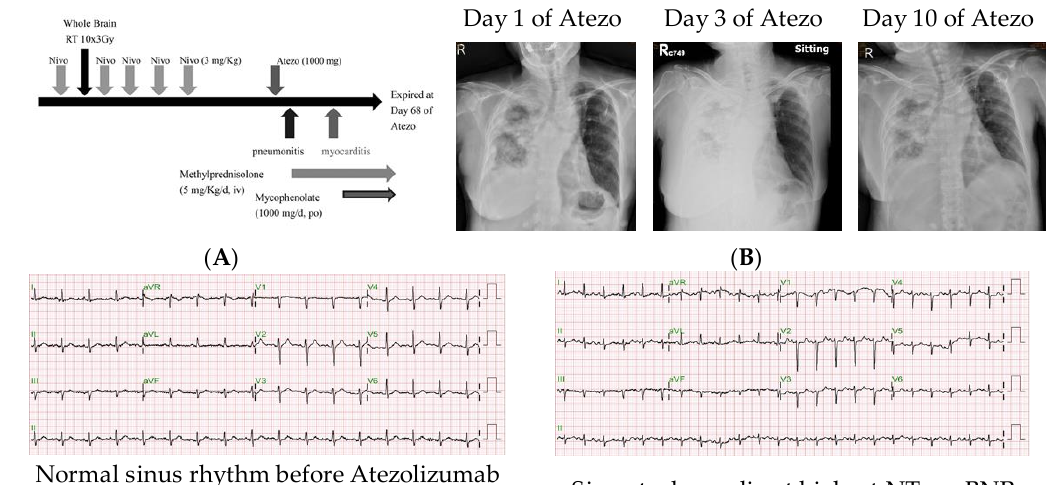
Figure 1. Clinical course of the presented patient. ( A ) Scheme of immune checkpoint inhibitor treatment course for the patient with brain metastatic lung adenocarcinoma. ( B ) Chest X-ray films demonstrated Atezolizumab (Atezo)-associated pneumonitis. ( C ) Electrocardiography of the patient before and after Atezolizumab administration. Nivo = nivolumab; RT = radiotherapy; NT-proBNP = N-terminal pro-brain natriuretic